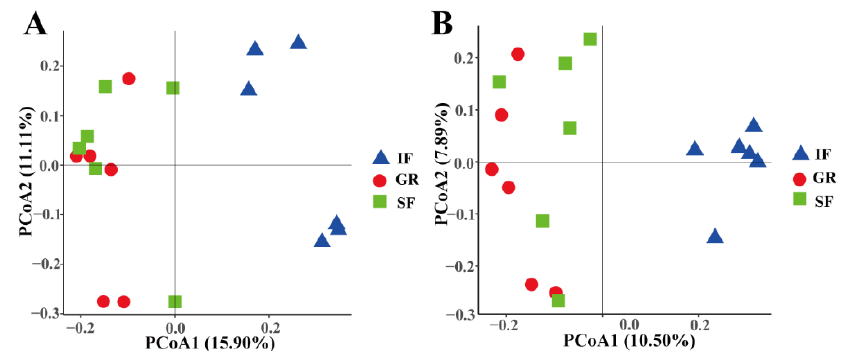
Figure 1. Principal coordinate analysis (PCoA) plots of the bacterial and archaeal community compositions in the rumen fluid of the goat kids among the three feeding systems using an unweighted UniFrac metric. The percentages of variation explained by PC1 and PC2 are indicated on the axes. ( A ) The PCoA plot of the bacterial community composition; ( B ) the PCoA plot of the archaeal community composition.